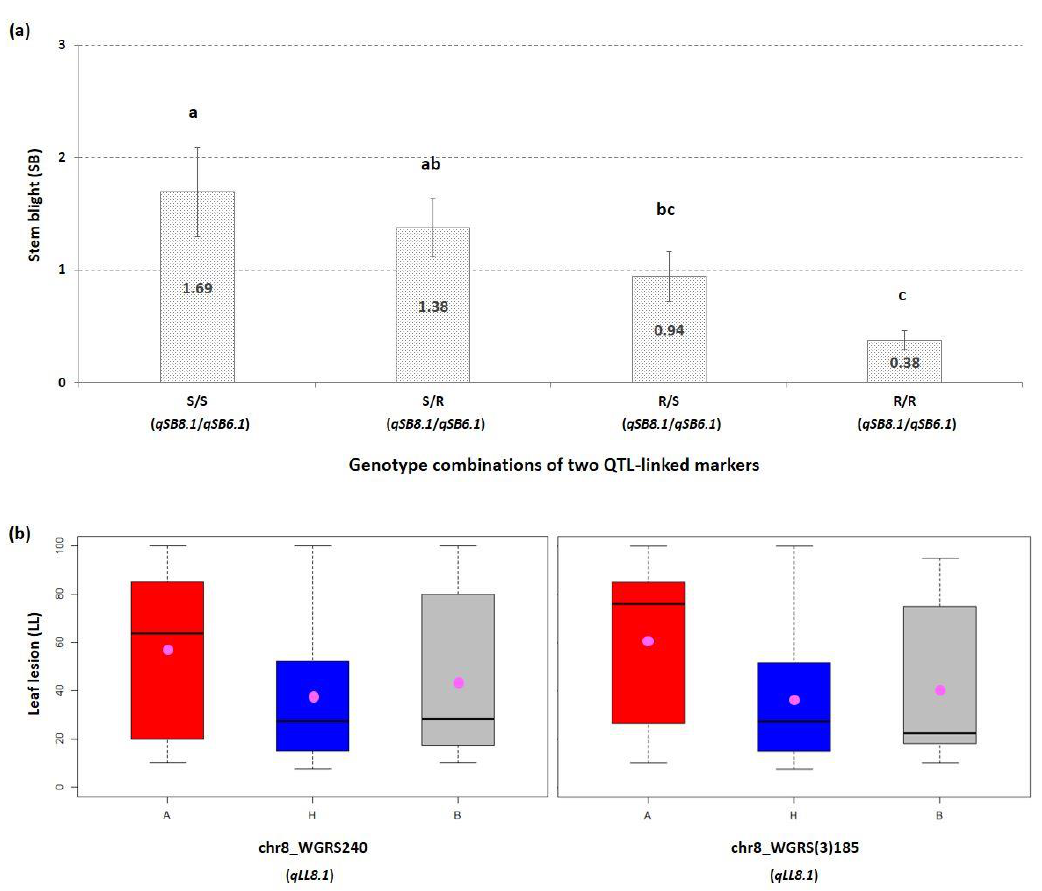
Figure 4. Comparison of GSB resistance in F 2 population according to genotypes for QTLs qSB8.1 and qSB6.1 ( a ) The mean of stem blight (SB) according to genotypes of two QTL-linked markers (chr8_WGRS(3)185 and chr6_WGRS(3)092) where R, resistant genotype and S, susceptible genotype. Bars on graphs indicate standard error and different small letters (a, ab, bc and c) refer to significant differences ( p < 0.05) according to Duncan multiple range test. ( b ) Box plots of tightly linked SNP markers to QTL for leaf lesion (LL) trait in the F 2 population. A, genotype of female parent (‘920533’); B, genotype of male parent (‘PI 189225’); H, genotype of heterozygote. The pink dots within the boxplots represent the mean of lines harboring respective alleles.